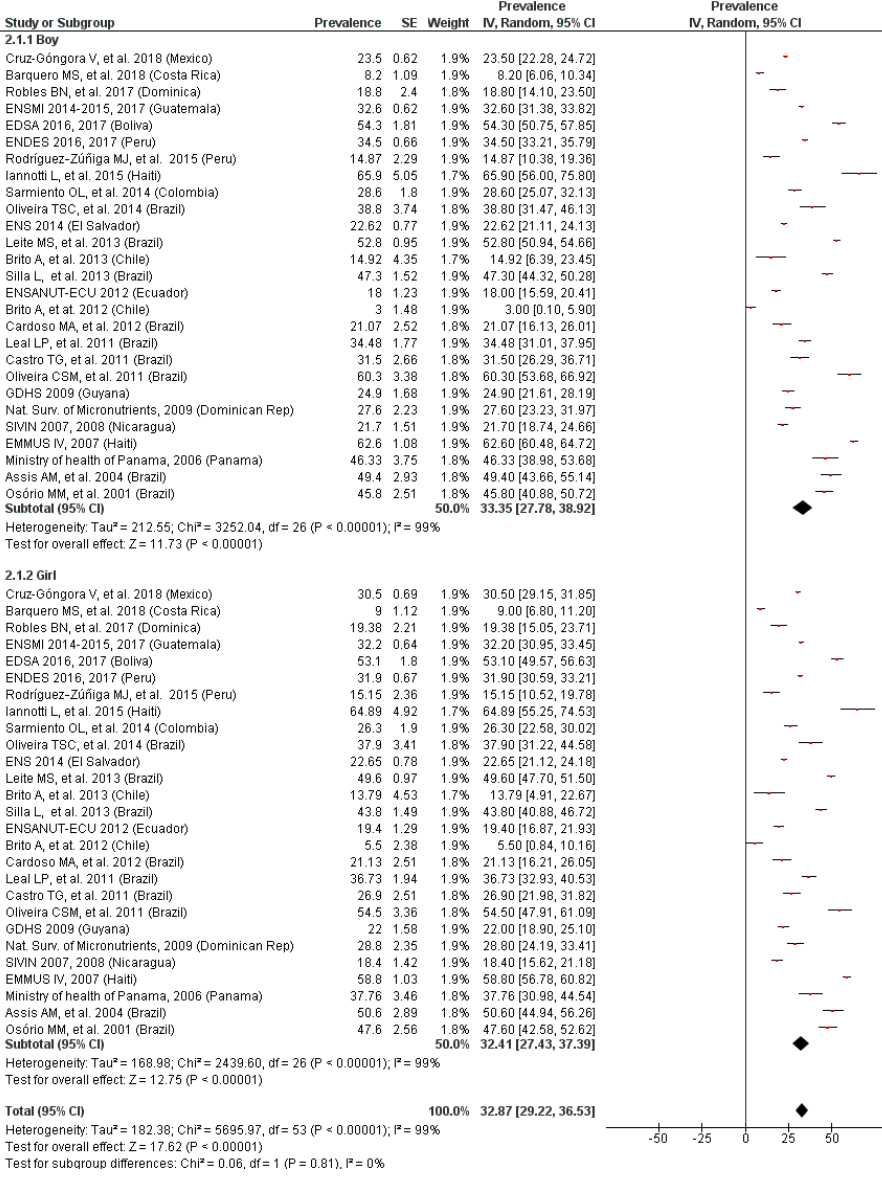
Figure 3. Prevalence of anemia in preschool children by gender.